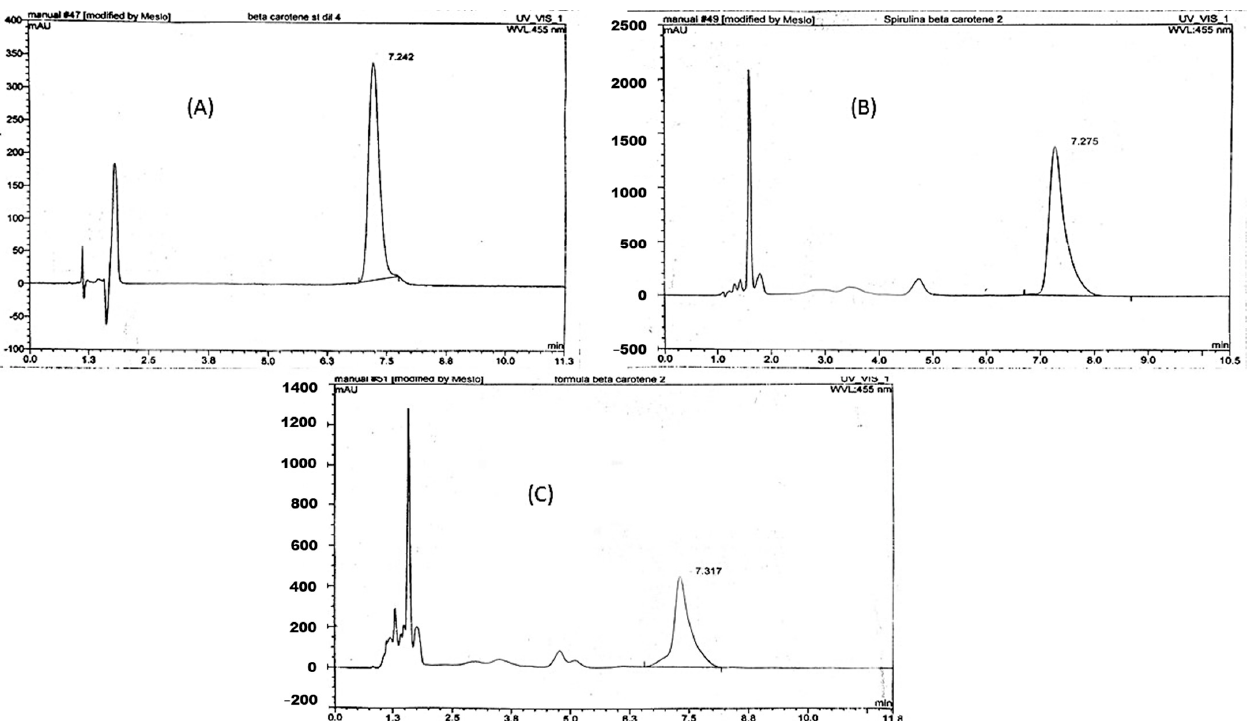
Figure 7. HPLC chromatogram of β -carotene in ( A ): reference standard; ( B ): SP and ( C ): NCF.